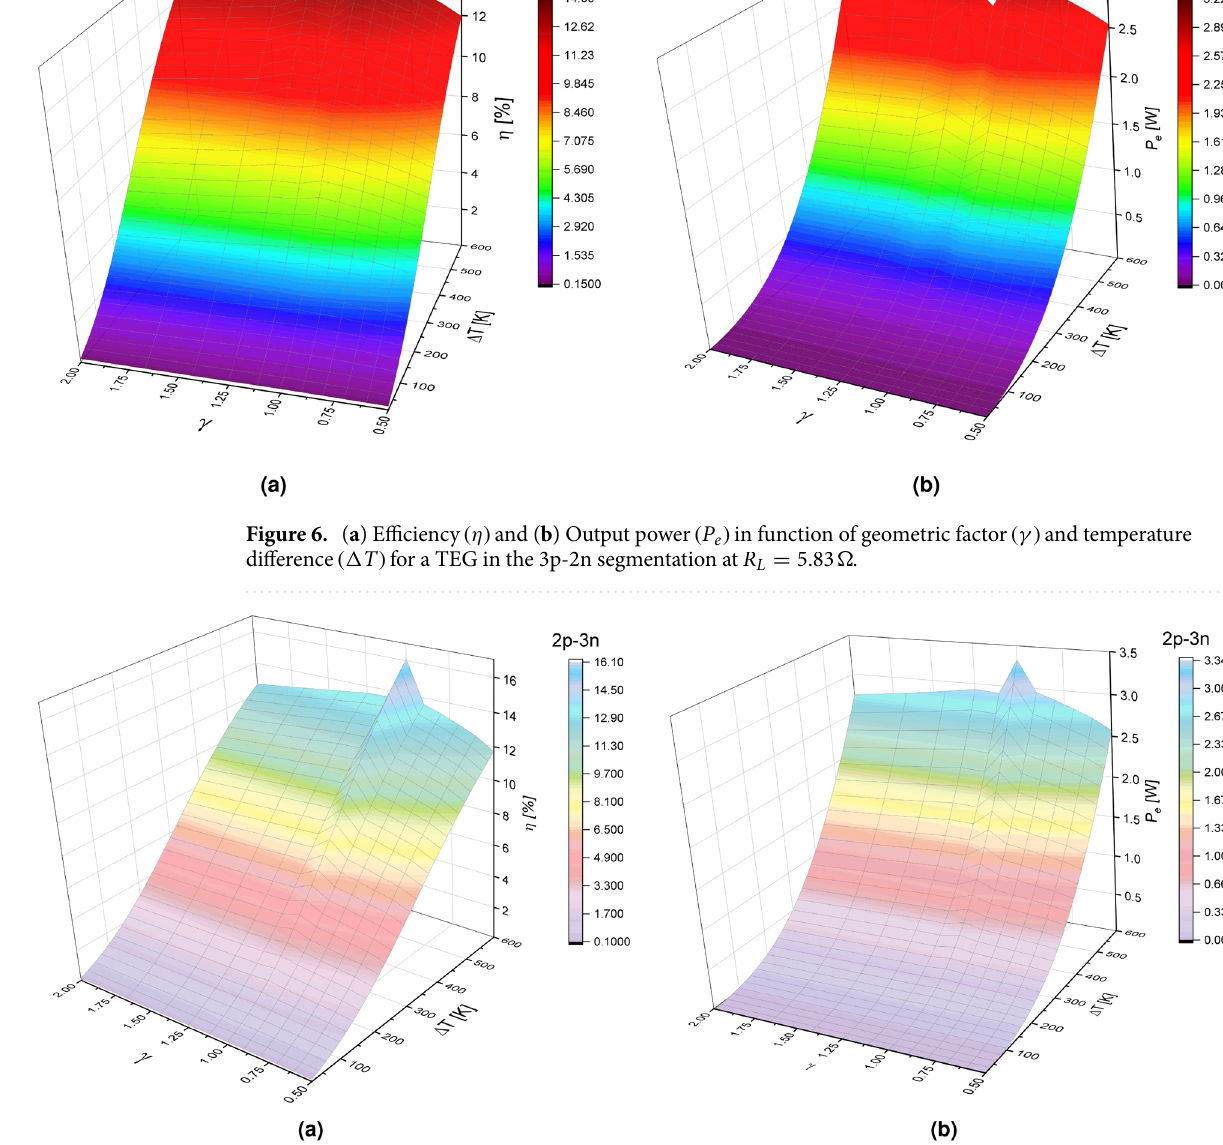
Figure 7. ( a ) Efficiency (η) and ( b ) Output power ( P e ) in function of geometric factor (γ) and temperature difference (� T ) for a TEG in the 2p-3n model at R L = 5.83 (cid:31)